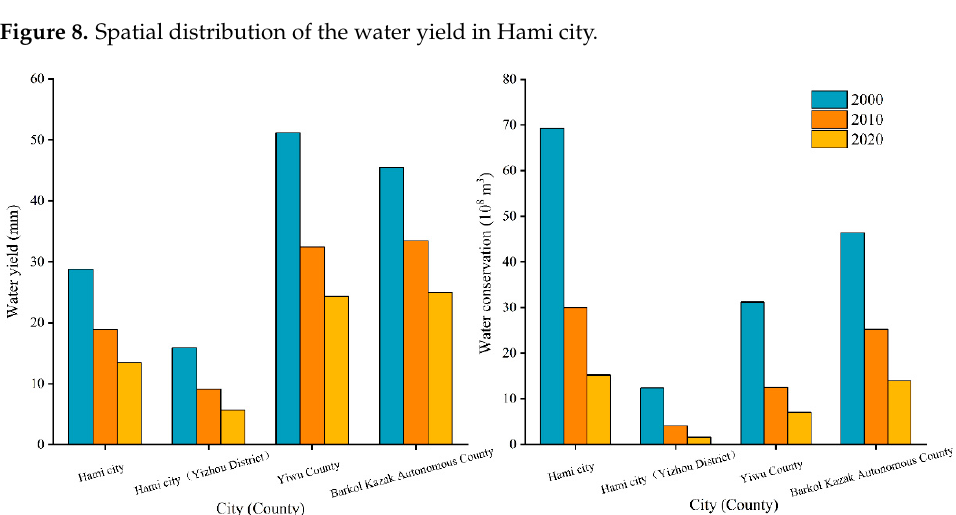
Figure 9. Average water yield and total water conservation by county in Hami city, 2000–2020.